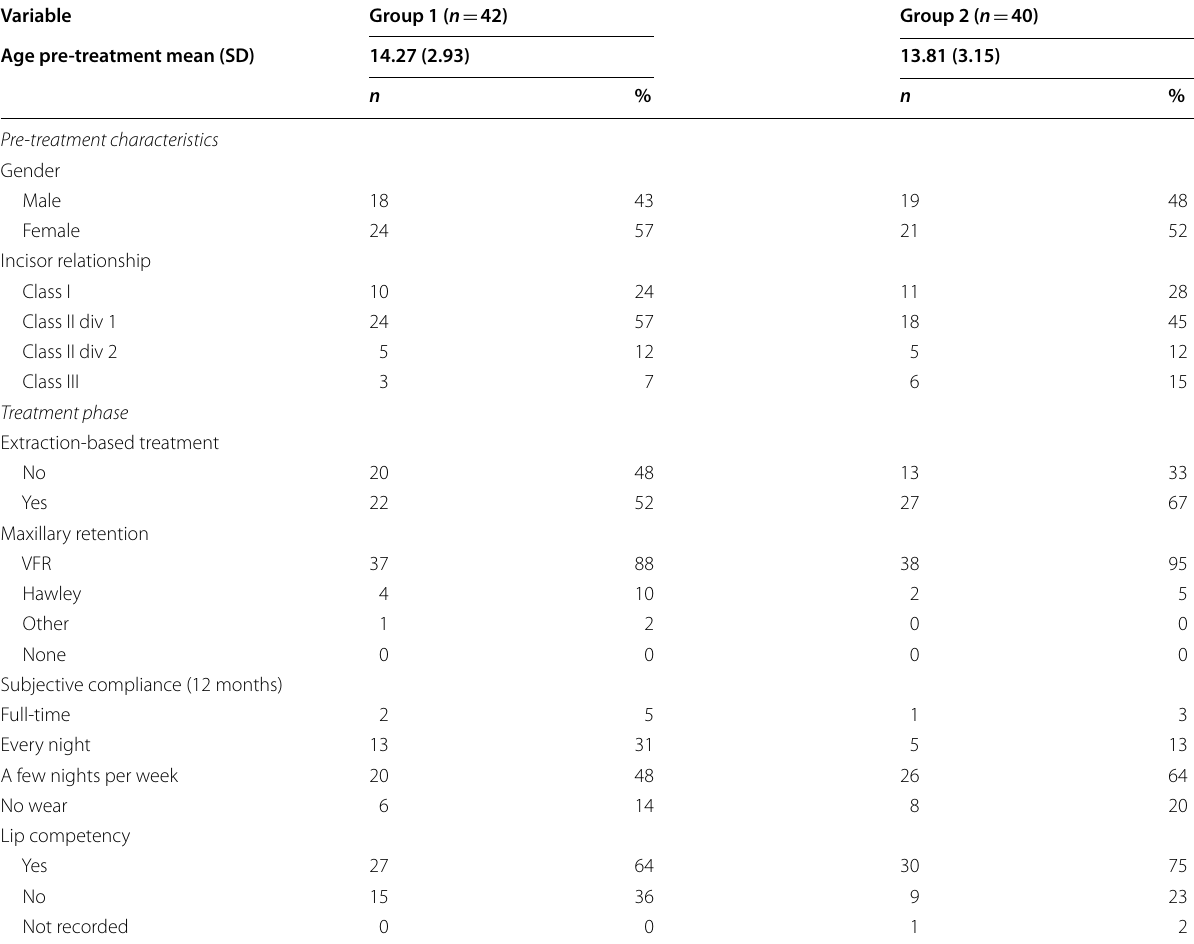
Table 1 Pre-treatment characteristics, treatment and retention regimes (Group 1: Residual overjet group; Group 2: Normal overjet group; PAE: Pre-adjusted edgewise